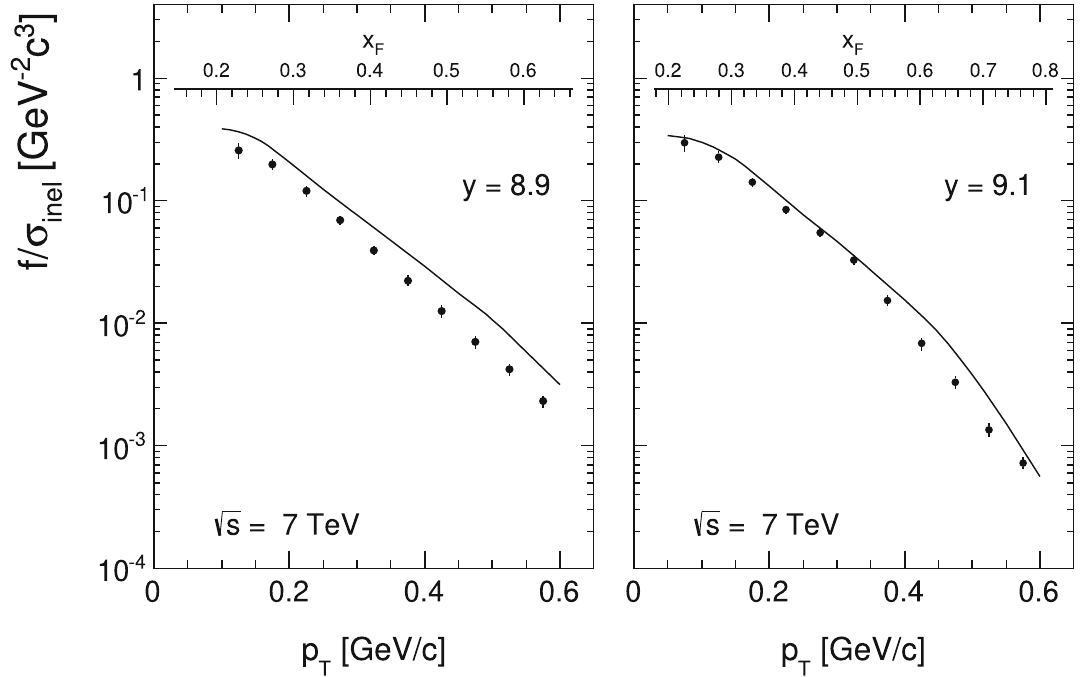
√ s = 7 TeV (data points from LHCf) compared to